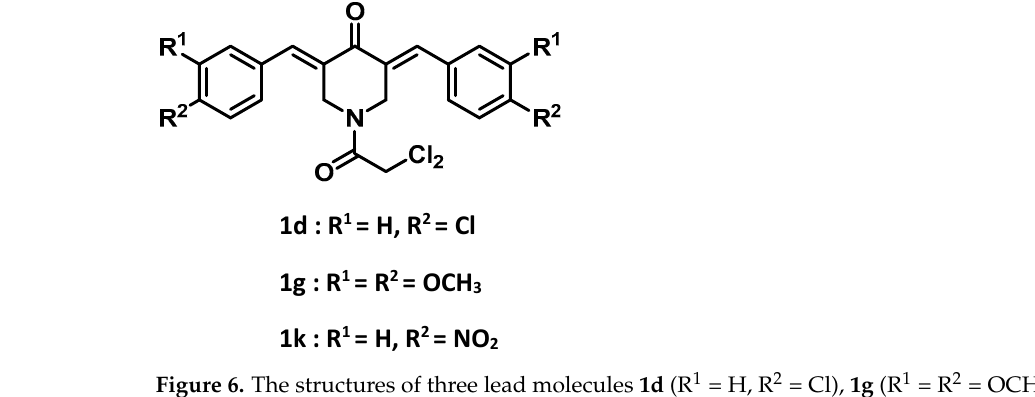
Figure 6. The structures of three lead molecules 1d (R 1 = H, R 2 = Cl), 1g (R 1 = R 2 = OCH 3 ), and 1k (R 1 = H, R 2 = NO 2 ).